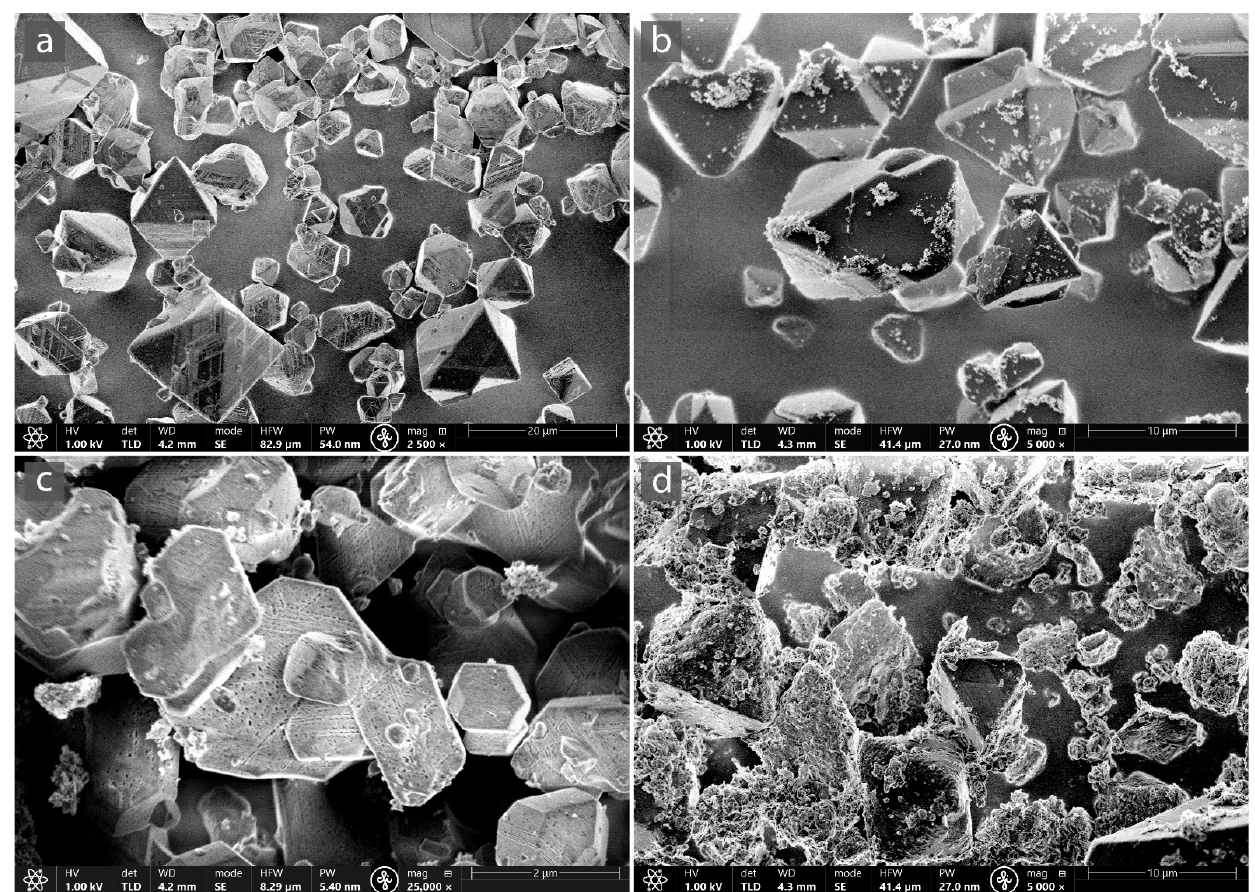
Figure 6. SEM image of ( a ) CuBTC, ( b ) CuBTC-A-15, ( c ) CuBTC-BC-15, ( d ) CuBTC-Mt-15.